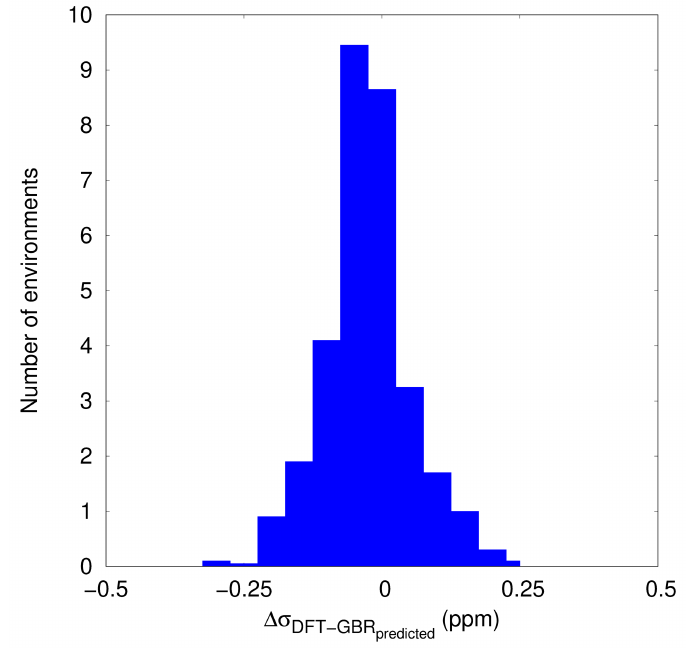
Figure 6. Distribution of the differences between the isotropic shielding values computed with DFT and those predicted with the ML-GBR method. Only silicon atomic environments are con- sidered. The histograms are obtained with an interval of 0.05 ppm in the count of the number of atomic environments.